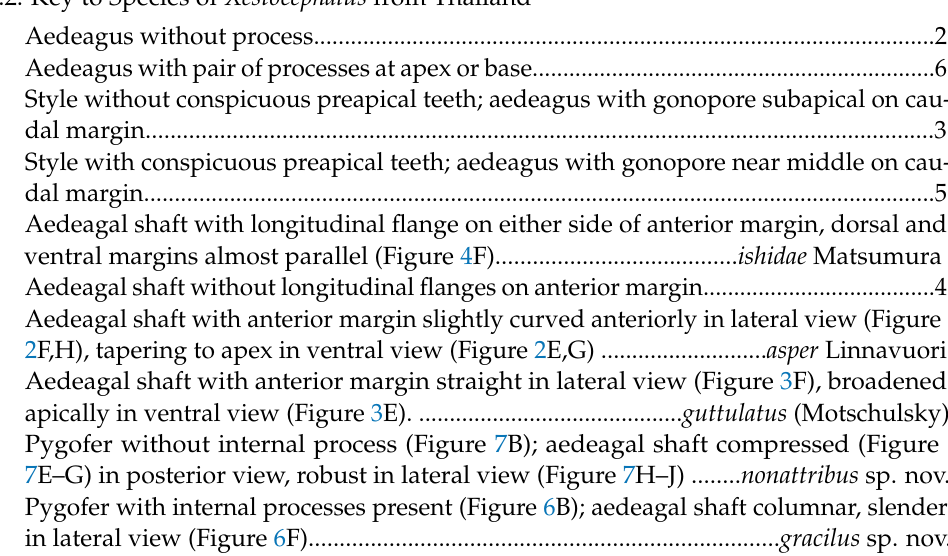
3. Aedeagal shaft with longitudinal flange on either side of anterior margin, dorsal and